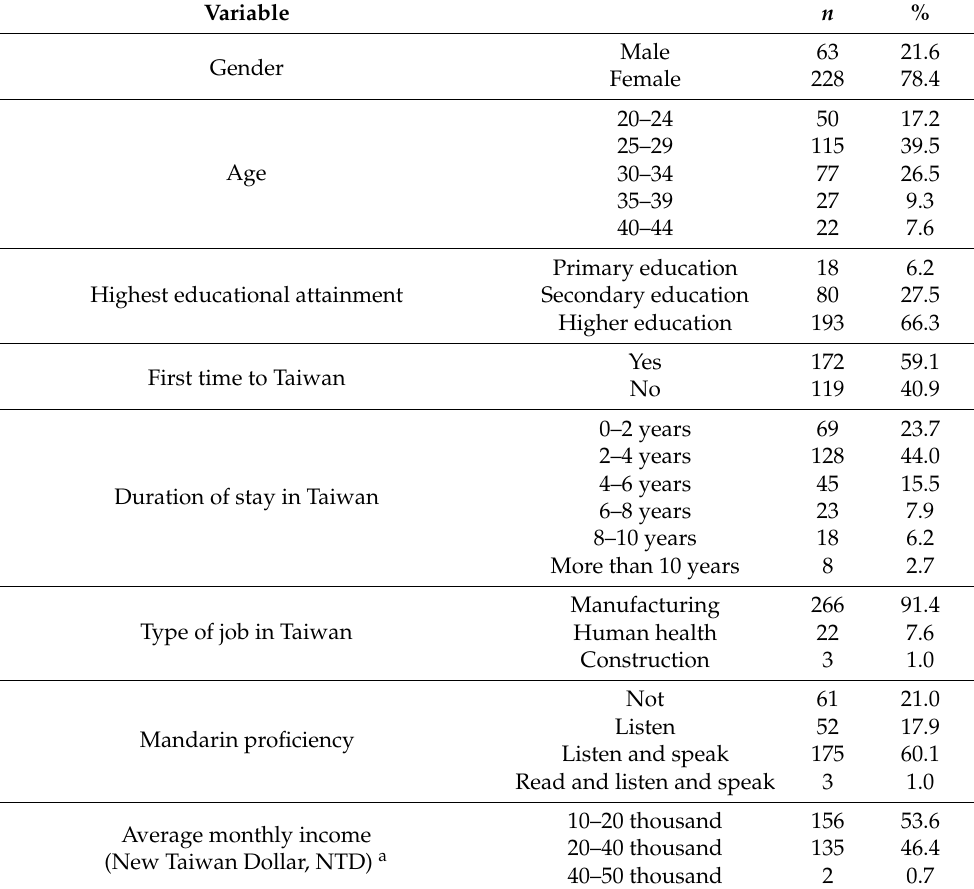
Table 1. Sociodemographic characteristics and cues to action of the participants of the present study ( n = 291). Variable